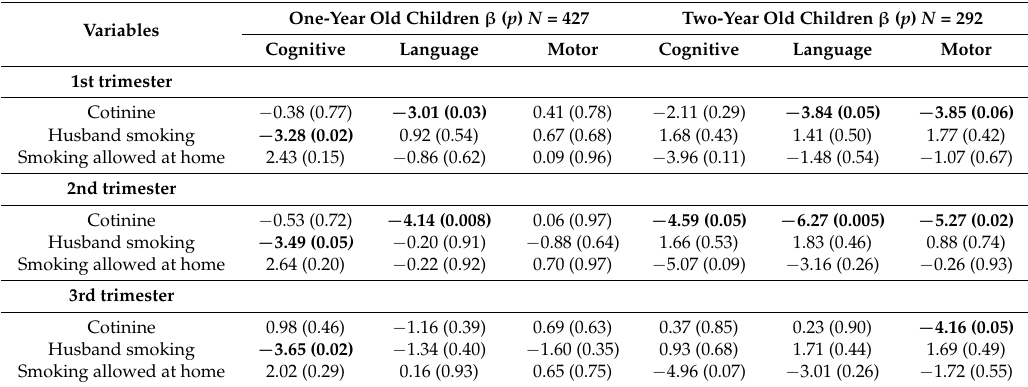
Table 4. ETS exposure during pregnancy based on the selected indicators and child psychomotor development at the age of one and two years. The multivariate linear regression